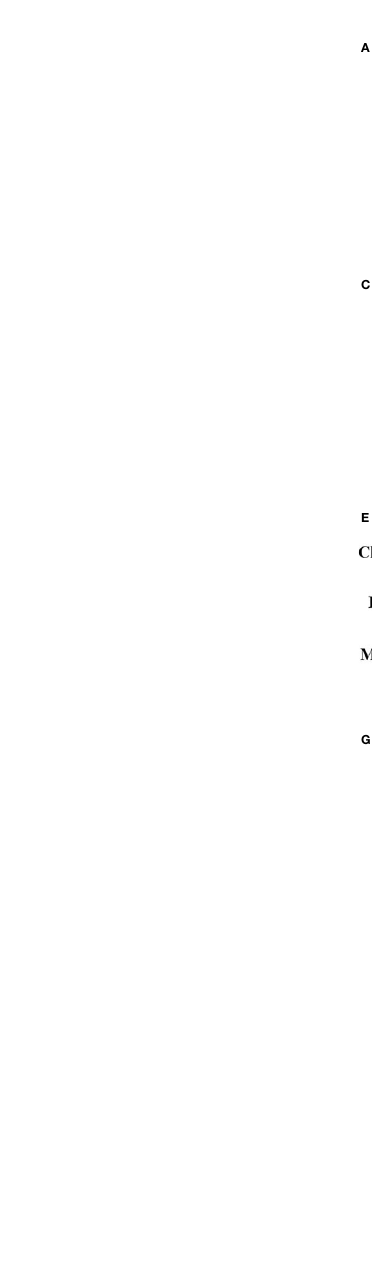
FIGURE 4 | C. trachomatis infection alters the intracellular transport of MHC-I molecules in JAWS-II DCs. (A – F) JAWS-II DCs were infected with C. trachomatis L2 for 24 h at MOI 100 and analyzed by (A, B) confocal microscopy, (C, D) fl ow cytometry and (E, F) Western blot. (A, B) Immuno fl uorescence staining of MHC-I with an anti-H-2K b mouse monoclonal antibody coupled to FITC showing non-infected (A) and infected (B) cells. Nuclei were stained with DAPI and chlamydial inclusions were detected with a rabbit anti-CT529 antibody and a secondary anti-rabbit Cy3-labeled antibody. Bars represent 10 um. (C) Representative FACS histograms showing the fl uorescence intensity of unstained (grey), non-infected (black line), and infected (red line) cells. Cell surface expression of MHC-I molecules was determined with a mouse monoclonal anti-H-2K b antibody and a secondary anti-mouse Alexa 647-conjugated antibody. (D) Bar graph shows the MFI of Alexa 647 and represents the mean ± SEM of three independent experiments. P-value = 0.013. The two-tailed Student ’ s unpaired t-test was performed. (E) Immunoblotting of clathrin, H-2K b , and MOMP in total cell lysates of non-infected and infected JAWS-II DCs. (F) Data represent the densitometry quanti fi cation and show the mean ± SEM of three independent experiments. P-value = 0.4127. The two-tailed Student ’ s unpaired t-test was performed. (G – I) MHC-I molecules recycling ability was measured by fl ow cytometry at the indicated periods by non-infected and infected JAWS-II DCs with C. trachomatis L2 for 24 h at MOI 100. (G, H) Representative FACS pro fi les of anti-H-2K b antibody recycling by non-infected (G) and infected (H) cells. (I) The curves show the percentage of anti-H-2K b (Alexa 647) recycling over time and data represent differences between the hyperboles from non-infected (blue line) versus infected (red line) cells of three independent experiments. P-value = 0.0066. No linear regression analysis shows that hyperboles are signi fi cantly different. The meaning of the symbol "*" is *P < 0.05 and the P value of NS in (F) is